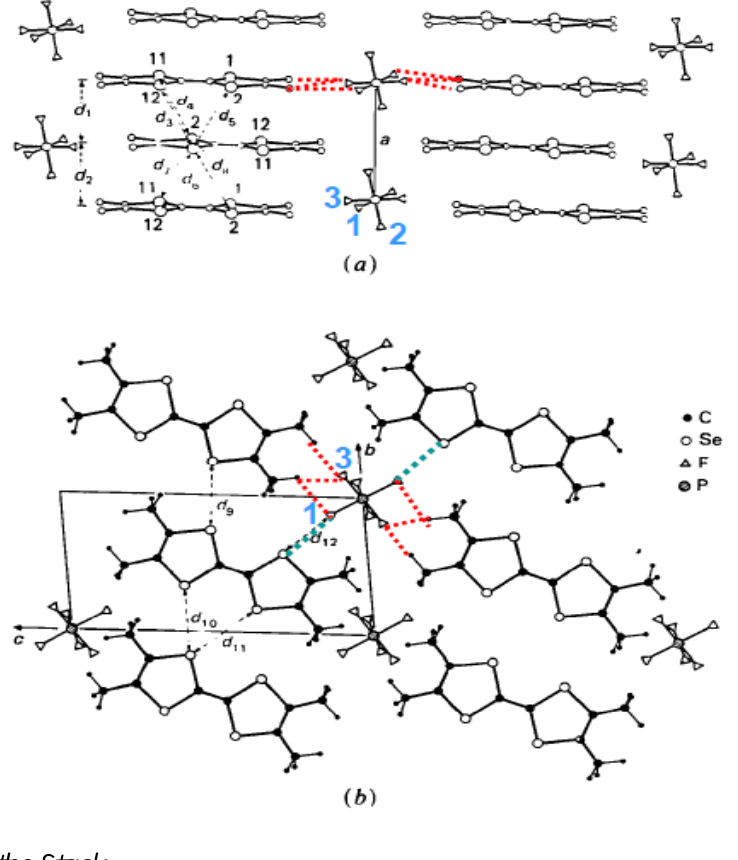
Figure 1. Structure of (TMTSF) PF : ( a ) Projection in the (a, [011]) plane; ( b ) Projection 2 6 along a. The F atoms are labeled. In (b) the methyl groups located in the low temperature neutron scattering structural refinement [11] are shown. The shortest F(1)-Se distances, F(1)-H and F(3)-H bonds are indicated by the blue and red dotted lines